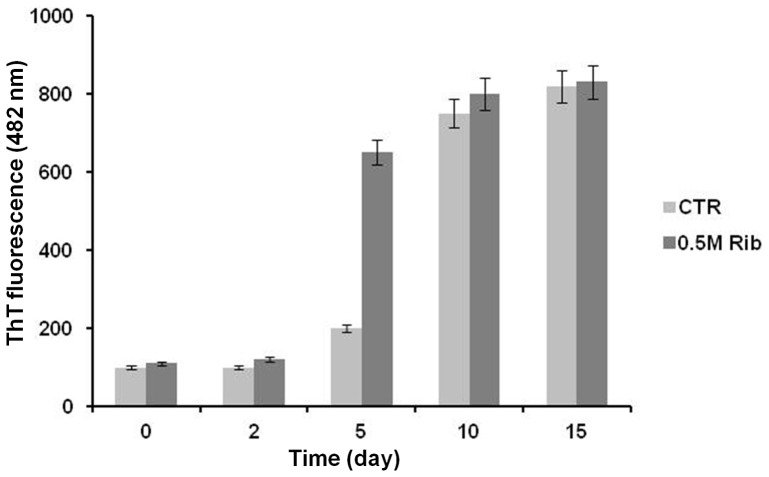
Effect of ribosylation on the amyloid formation for the W7FW17F apomyoglobin.W7FW14F apomyoglobin (40 µM) was incubated in the absence (light gray bar) and in the presence of 0.5M D-ribose (dark grey bar) and aliquots of each sample at different incubation time intervals were monitored by ThT fluorescence. The average value (±SD) of a quadruplicate experiment is plotted.